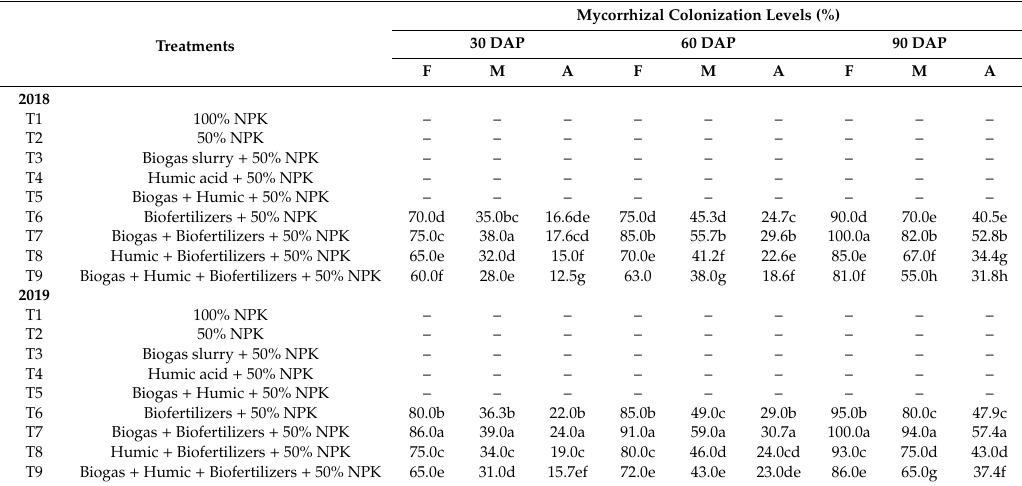
Table 6. Mycorrhizal colonization levels in the roots of maize treated with organic and biofertilizers alone or in